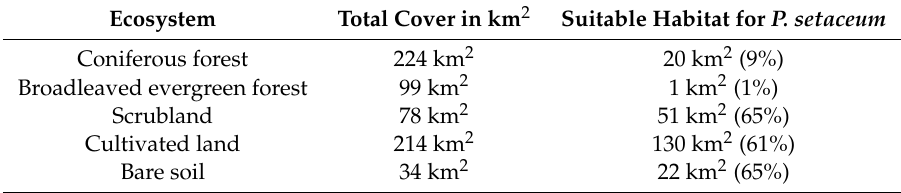
Table 3. Projected suitable habitat for P. setaceum within the coniferous forest, broadleaved evergreen forest, shrubland, cultivated land, and bare soil of La Palma as total cover of ecosystem, total suitable habitat for P. setaceum, and percentage cover of suitable habitat for P. setaceum .